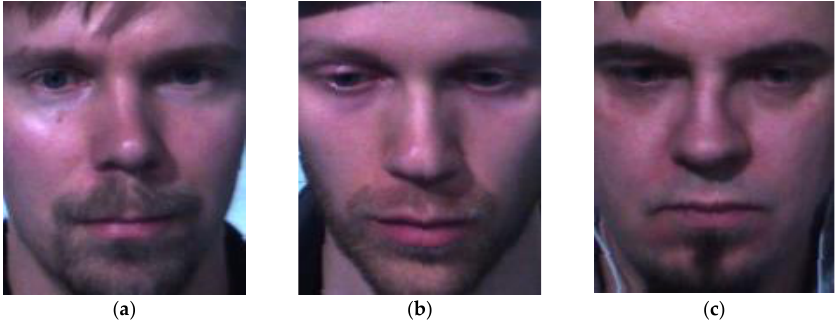
Figure 14. Correct recognition results on the SMIC dataset: ( a ) positive, ( b ) negative, and ( c ) surprise.